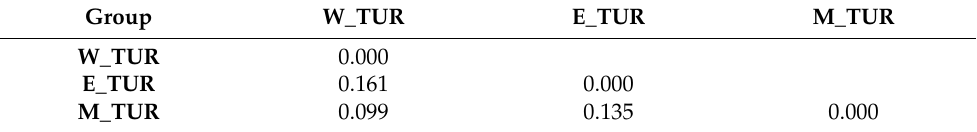
Table 1. Pairwise F ST genetic distances between the groups of Caucasian tur ( Capra caucasica ).